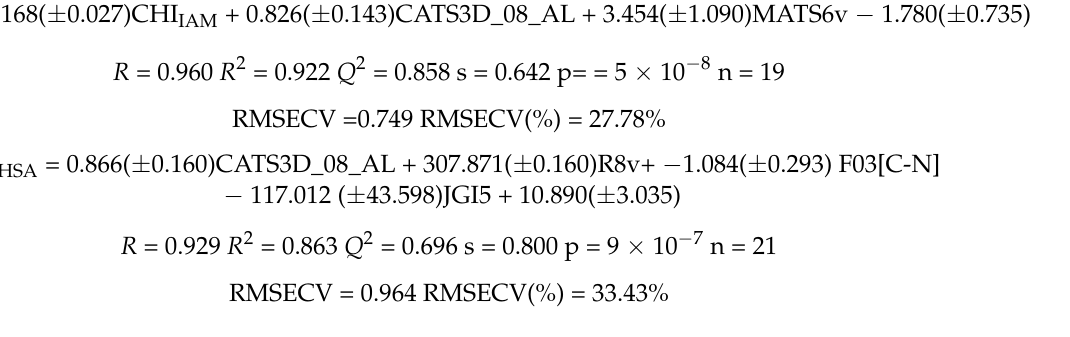
Table 2. Molecular descriptors calculated by the Dragon 7.0